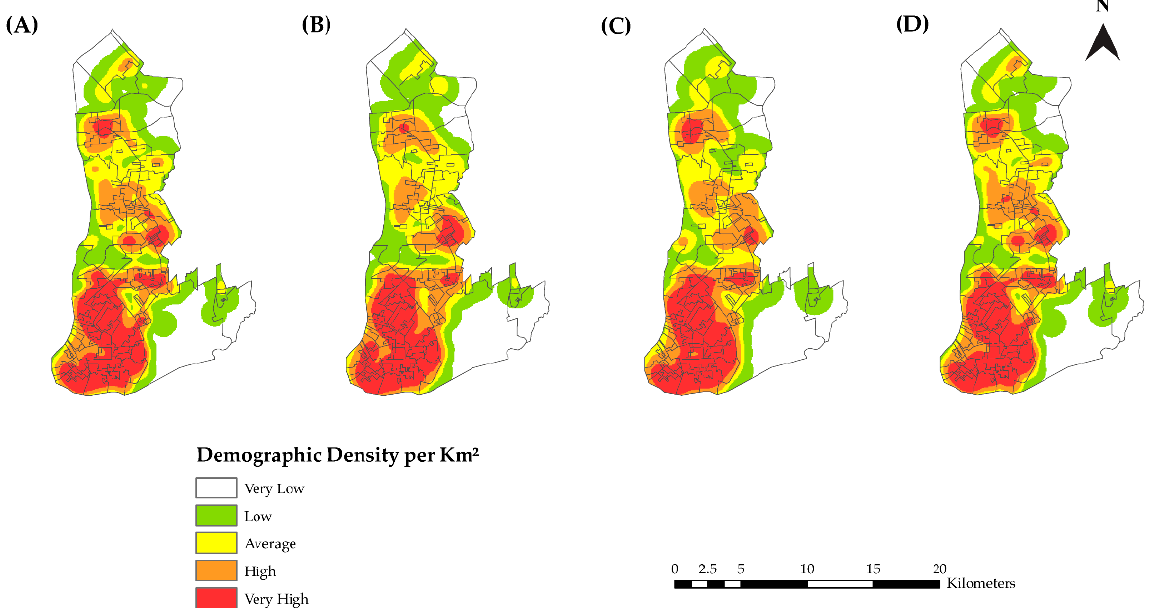
Figure 5. Map of the distribution of the density of new reported cases of HIV infections and AIDS.